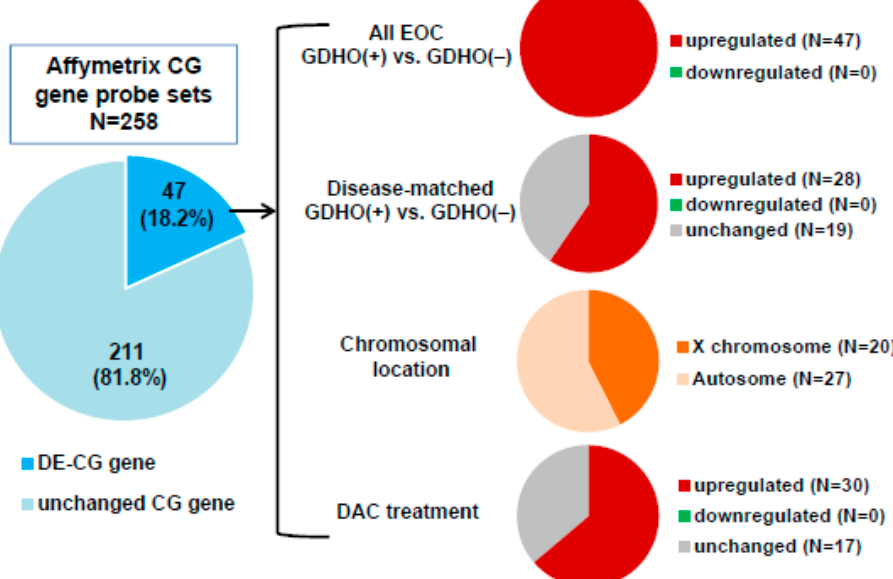
Figure 4. CG antigen genes are overexpressed in GDHO ( + ) EOC. A CG antigen gene list was obtained from the CT gene database [50]. Left: the proportion of CG genes (i.e., corresponding A ff ymetrix probes) di ff erentially expressed between GDHO ( + ) and GDHO (–) EOC ( p < 0.01) as determined by Affymetrix microarray. Right: Direction of expression change for the DEGs in all samples or disease-matched samples, their chromosomal localization, and the e ff ect of decitabine (DAC) treatment on their expression in cell lines, as determined by A ff ymetrix microarray. See Methods for cell lines and treatment details.